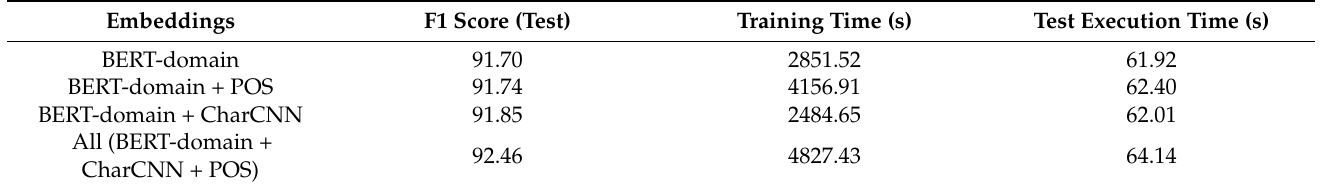
Table 2. Ablation test to investigate the impact of hidden features in our model utilizing BERT (feature-based).